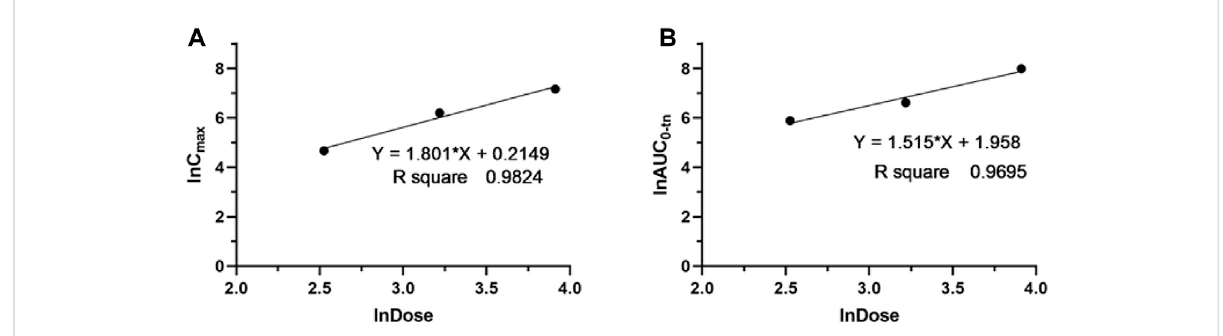
FIGURE 7 Dose proportionality of C max (A) and AUC 0-t (B) for glytrexate in plasma after a single oral administration of glytrexate at doses of 12.5, 25, and 50